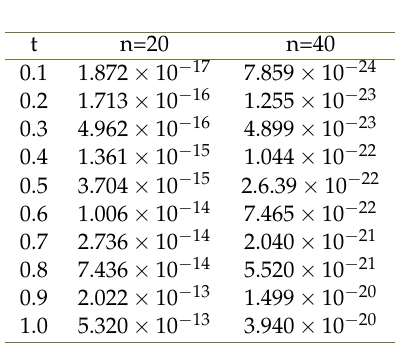
Table 4. The absolute errors | e N ( t ) | for Example 3, for n = 20 and n =